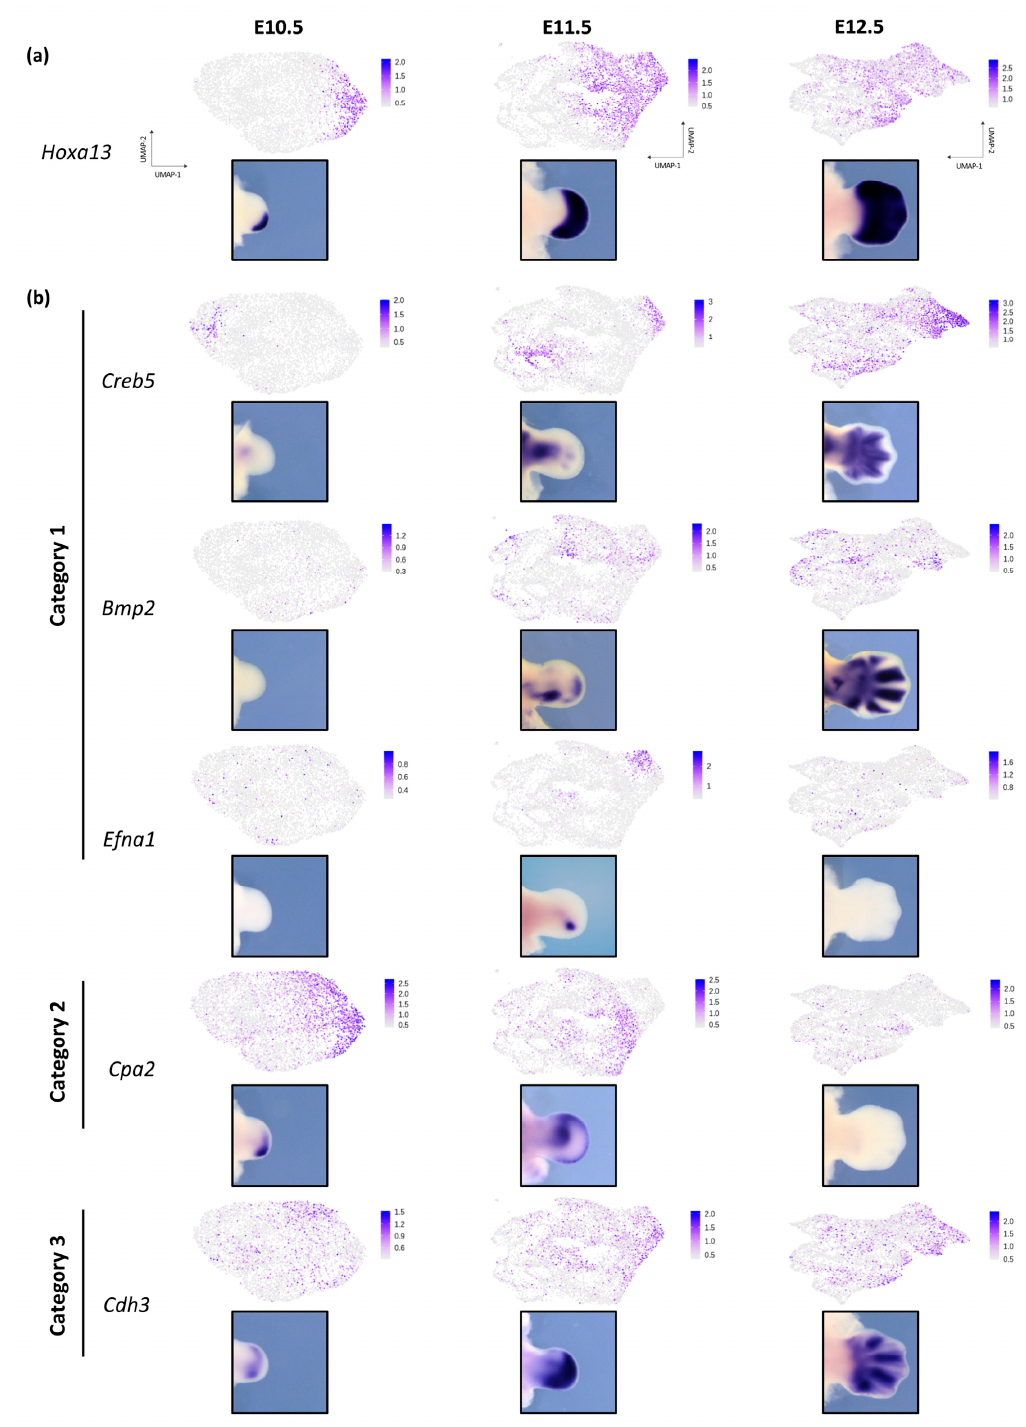
Figure 4. Dynamic expression of ‘distal’ genes during limb bud development. ( a ) UMAP visualization of the mesenchymal cells expressing Hoxa13 and whole-mount in situ hybridization for Hoxa13 in WT mouse forelimb bud at E10.5, E11.5 and E12.5. ( b ) UMAP visualization and whole-mount in situ hybridization of the distal genes Creb5, Bmp2 , Efna1 belonging to Category 1, Cpa2 belonging to category2 and Cdh3 belonging to Category 3, in E10.5, E11.5 and E12.5 WT mouse forelimb buds. Color scale represents the scaled expression for each